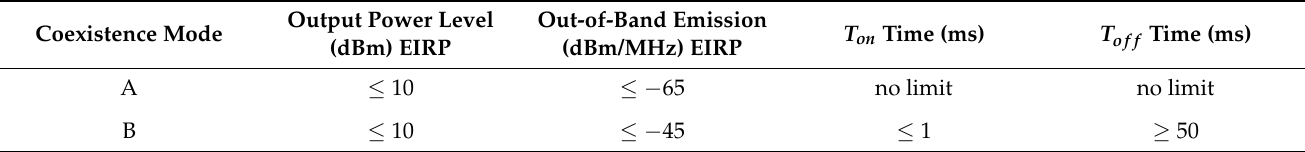
Table 1. Coexistence mode: ITS radiated emissions and timing [13]. N: number of interfering ITS road-side